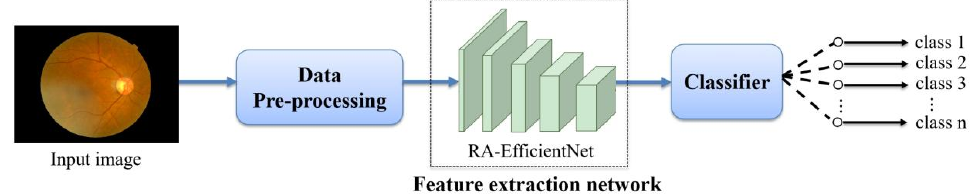
Figure 1. The pipeline of the DR diagnostic model.